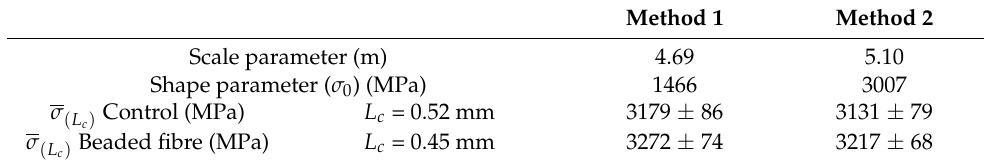
Table A1. Weibull parameters of bead-less E-glass fibres obtained from Methods 1 and